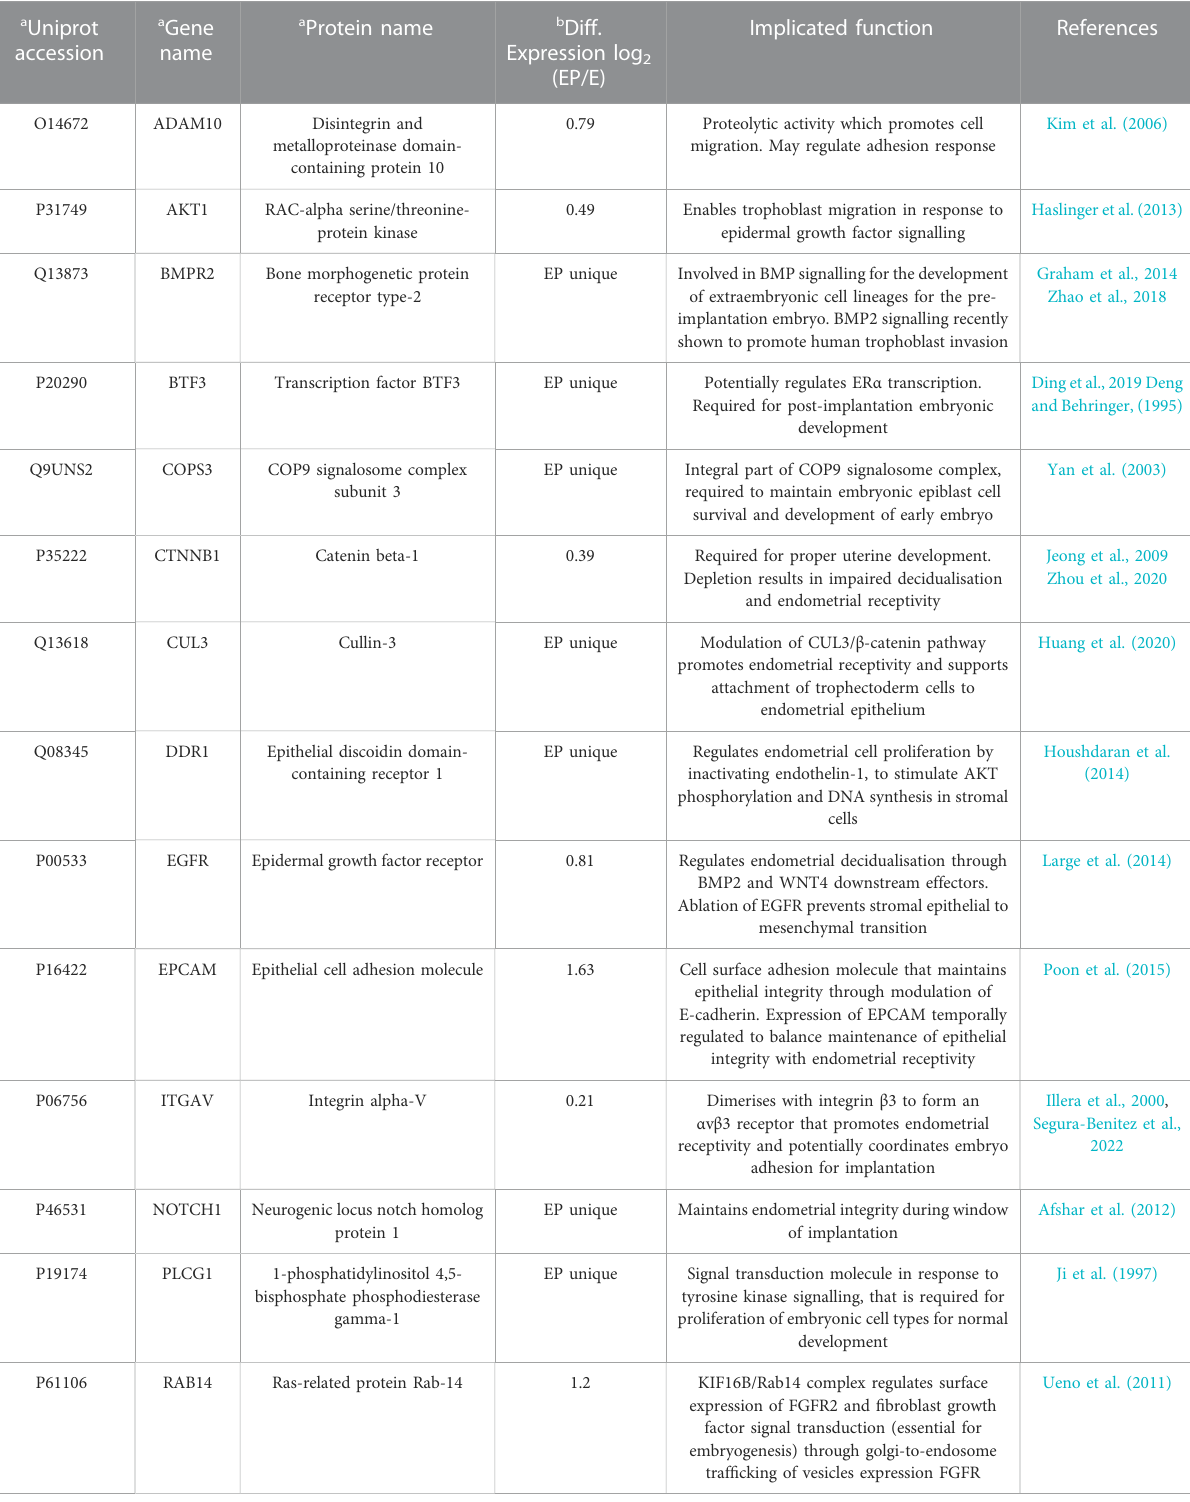
TABLE 1 Hormonal regulation of endometrial sEV proteome reprograms composition to support trophectoderm cell function and